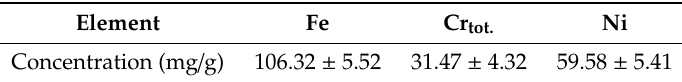
Table 6. Concentrations of Cr, Ni, and Fe in collected